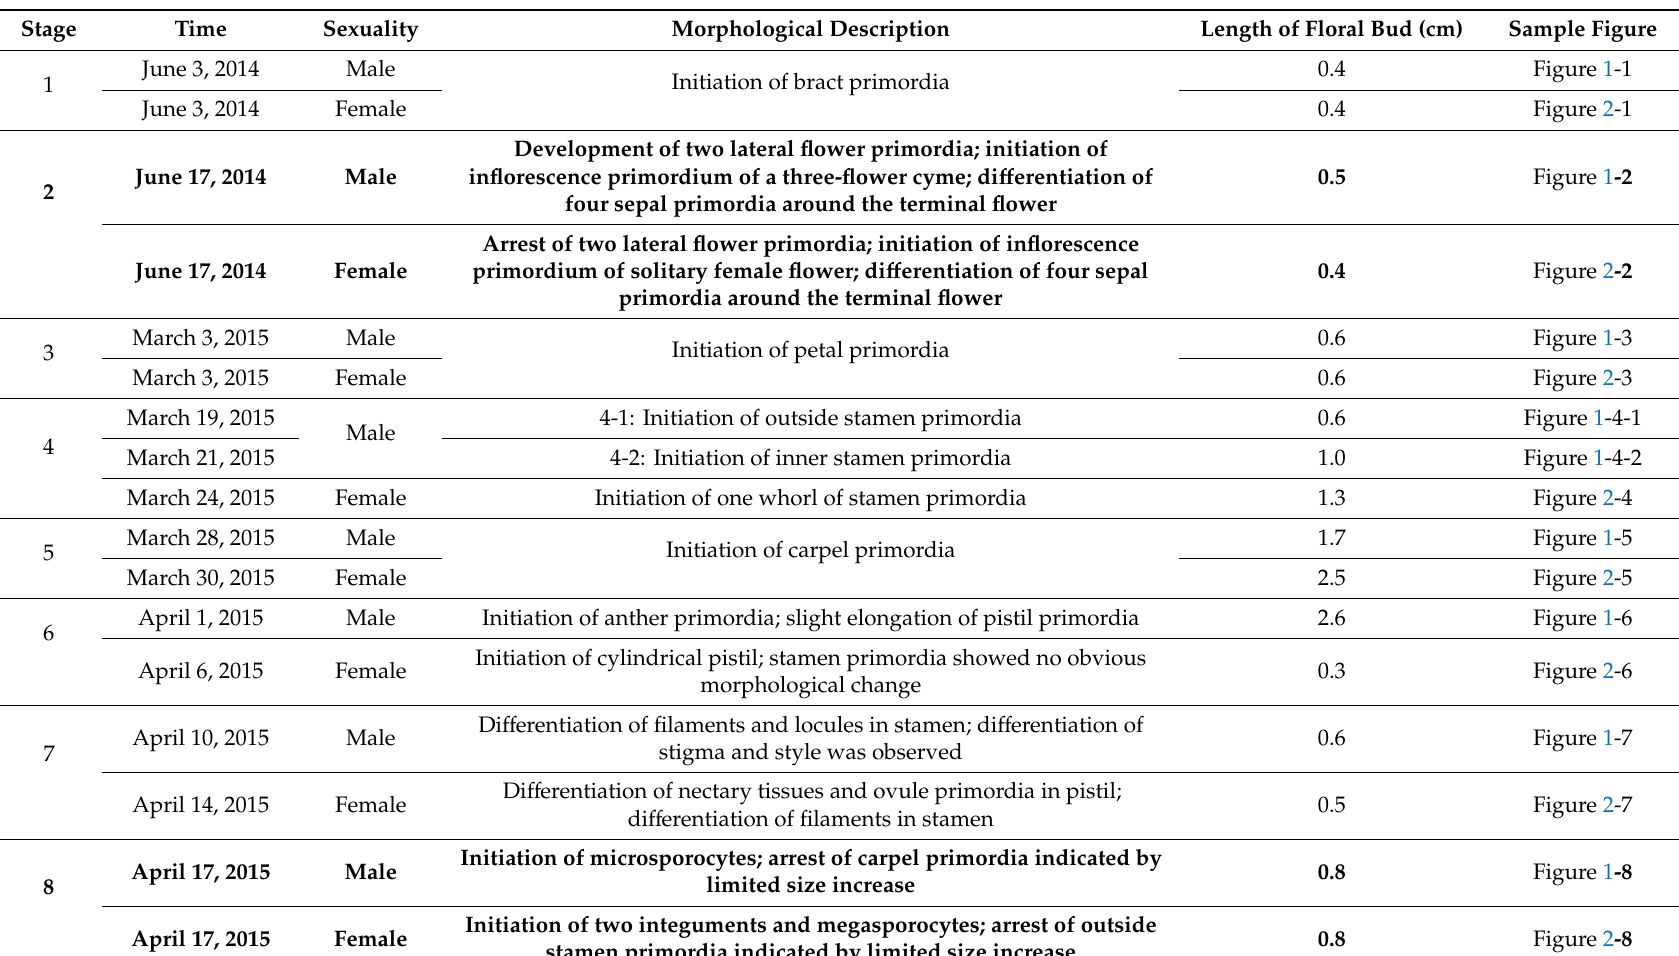
Table 1. Morphological descriptions and lengths of floral buds obtained from persimmon cultivar ‘Zenjimaru’ at the 11 developmental